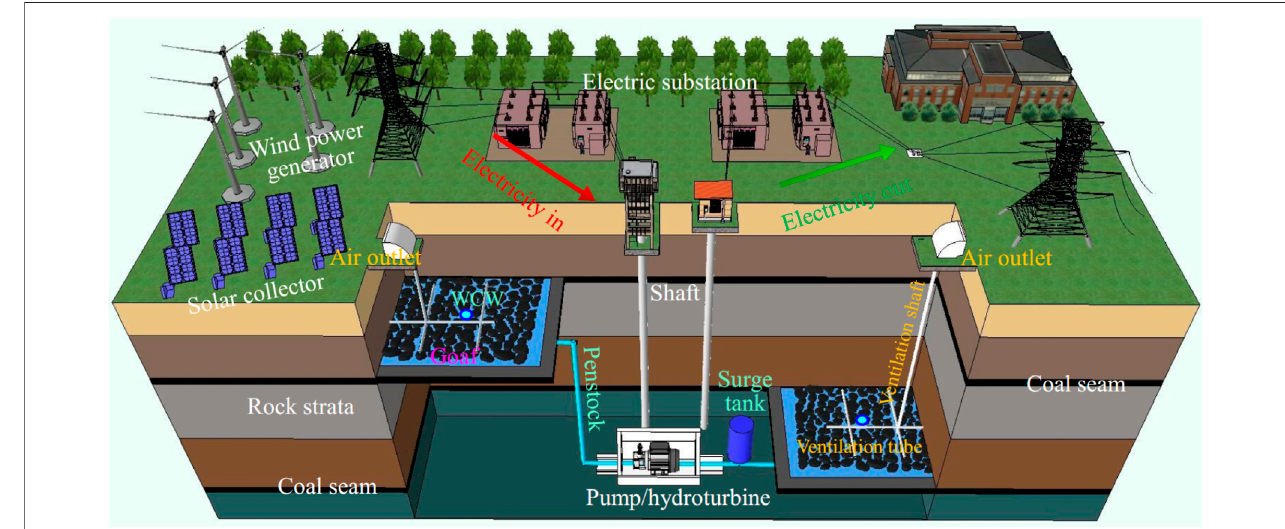
FIGURE 2 | Pumped hydro storage system using abandoned coal mine